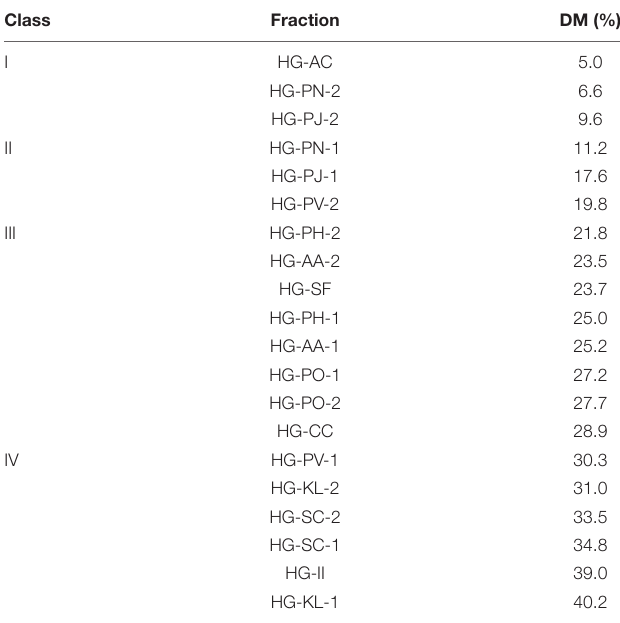
TABLE 2 | The degree of methyl-esterification (DM) of 20 HG pectins.